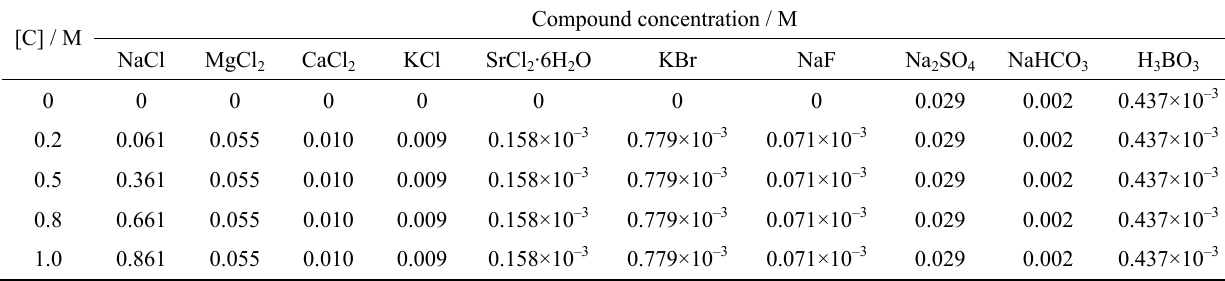
Table 1 Concentration of the main compound in